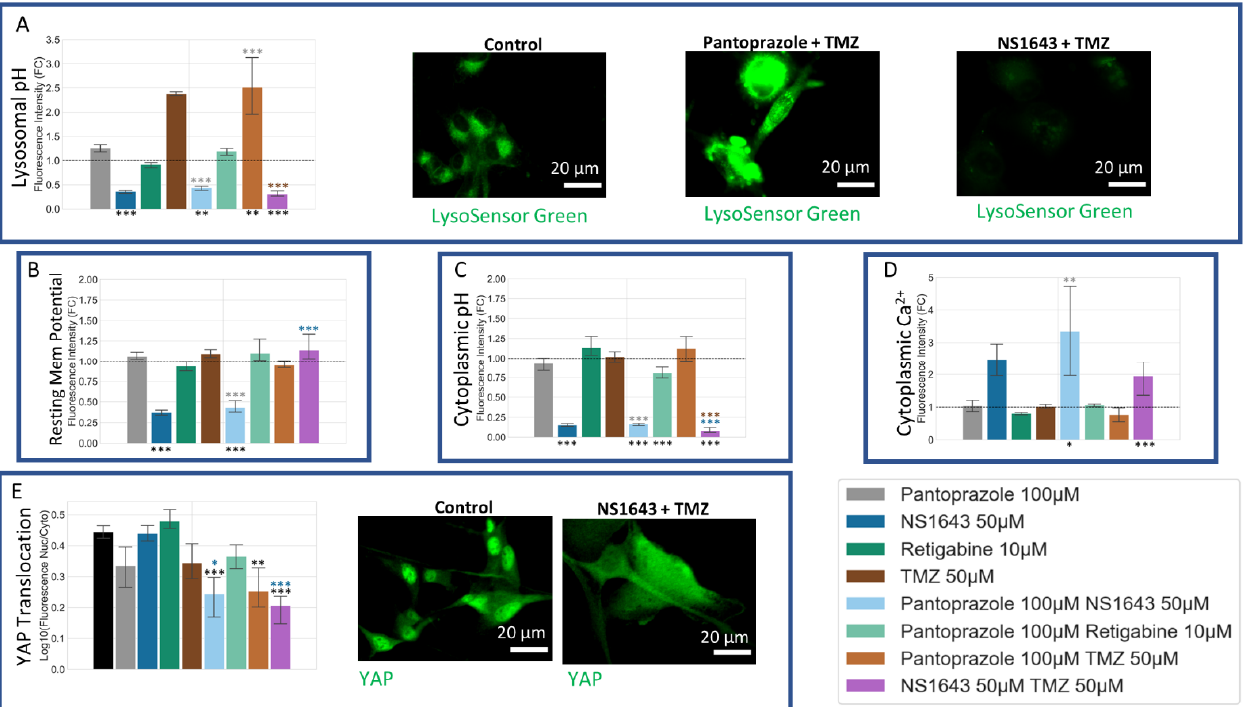
Figure 15. Voltage Dyes Showed that U87 Cells Treated with NS1643 and a Combination of NS1643 and Pantoprazole for 6 Days Showed a Hyperpolarization and YAP Increases its Translocation to the Cytoplasm in NS1643 or Pantoprazole with TMZ, and Pantoprazole with NS1643 Treatment. Immunofluorescence of cells was conducted and analyzed with CellProfiler for integrated fluores- cence intensity. Dye assays were analyzed for mean intensity, except for LysoSensor Green which was analyzed for integrated intensity. ( A ) Stain of lysosomal pH with LysoSensor Green, low levels indicate alkalization. ( B ) Dye indicator of membrane voltage, DiBAC4(3), low levels indicate hy- perpolarization. ( C ) Dye indicator of cytoplasmic pH, pHRodo Green, low levels indicate alkalization. ( D ) Dye indicator of cytoplasmic calcium, Fluo-4AM, high levels indicate an increase in calcium. ( E ) The ratio of nuclear to cytoplasmic Yes-associated protein (YAP), lower levels indicate translocation to the cytoplasm. Treatments corresponding to the colored bars are outlined in the figure itself. The log of the fold change in intensity was compared between single treatments and combined treatments, except the positive control, with significant values shown in the color of the treatment compared. The initial fluorescence intensities were compared to their corresponding con- trol, with significant values shown under the bars as, ***: p < 0.001, **: p < 0.01, * : p < 0.05 (one-way ANOVA with Tukey post hoc analysis n > 3 technical replicates).